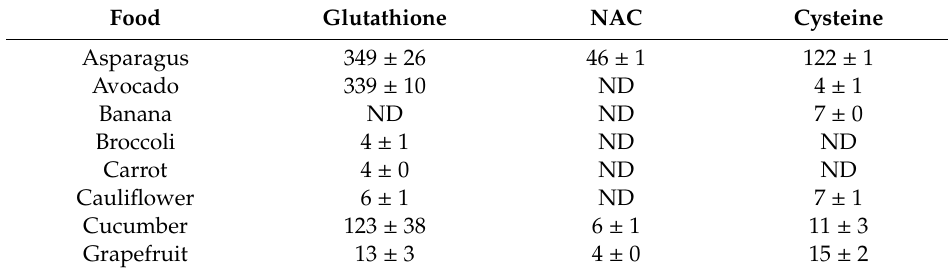
Table 2. Sulfur-rich fruits and vegetables (modified from [151], values reported as mean ± SD ( n =